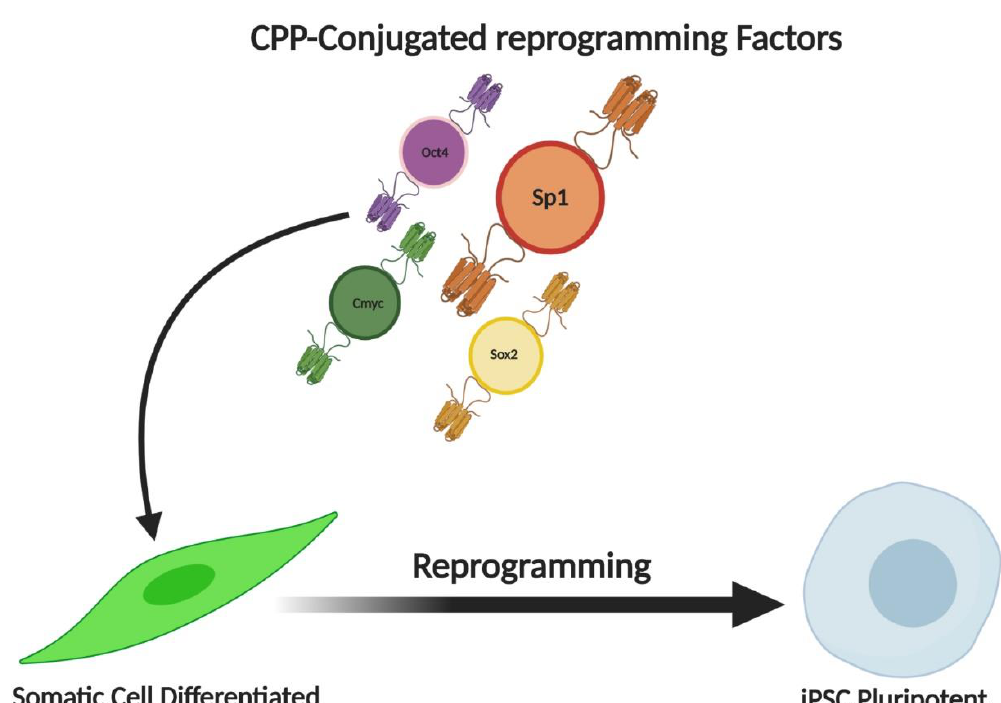
Figure 4. Potential role of Sp1 transcription factor in cellular reprogramming. Sp1 is one of the most important transcription factors that are associated with the major reprogramming factors Sox2, c-Myc, and Oct4, that are used for iPSC induction. Sp1 TF is an analog for Klf4 TF, thus Sp1 do play a major role in reprogramming process of cancer stem cells. Sp1 was also considered as a vital component involved in the conversion of somatic cells into pluripotent cells making it a target to increase the efficiency of reprogramming.